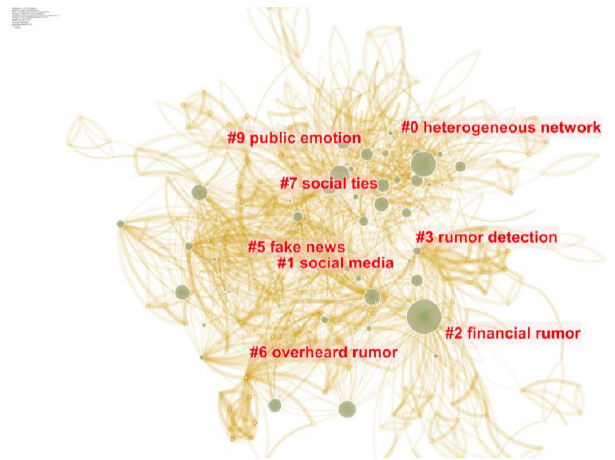
Figure 1. Keyword clustering map of WOS database.